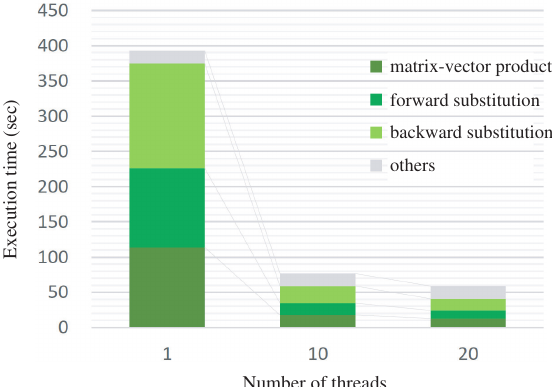
Figure 16. Breakdown of the execution time for the 101 × 101 × 102 mesh.